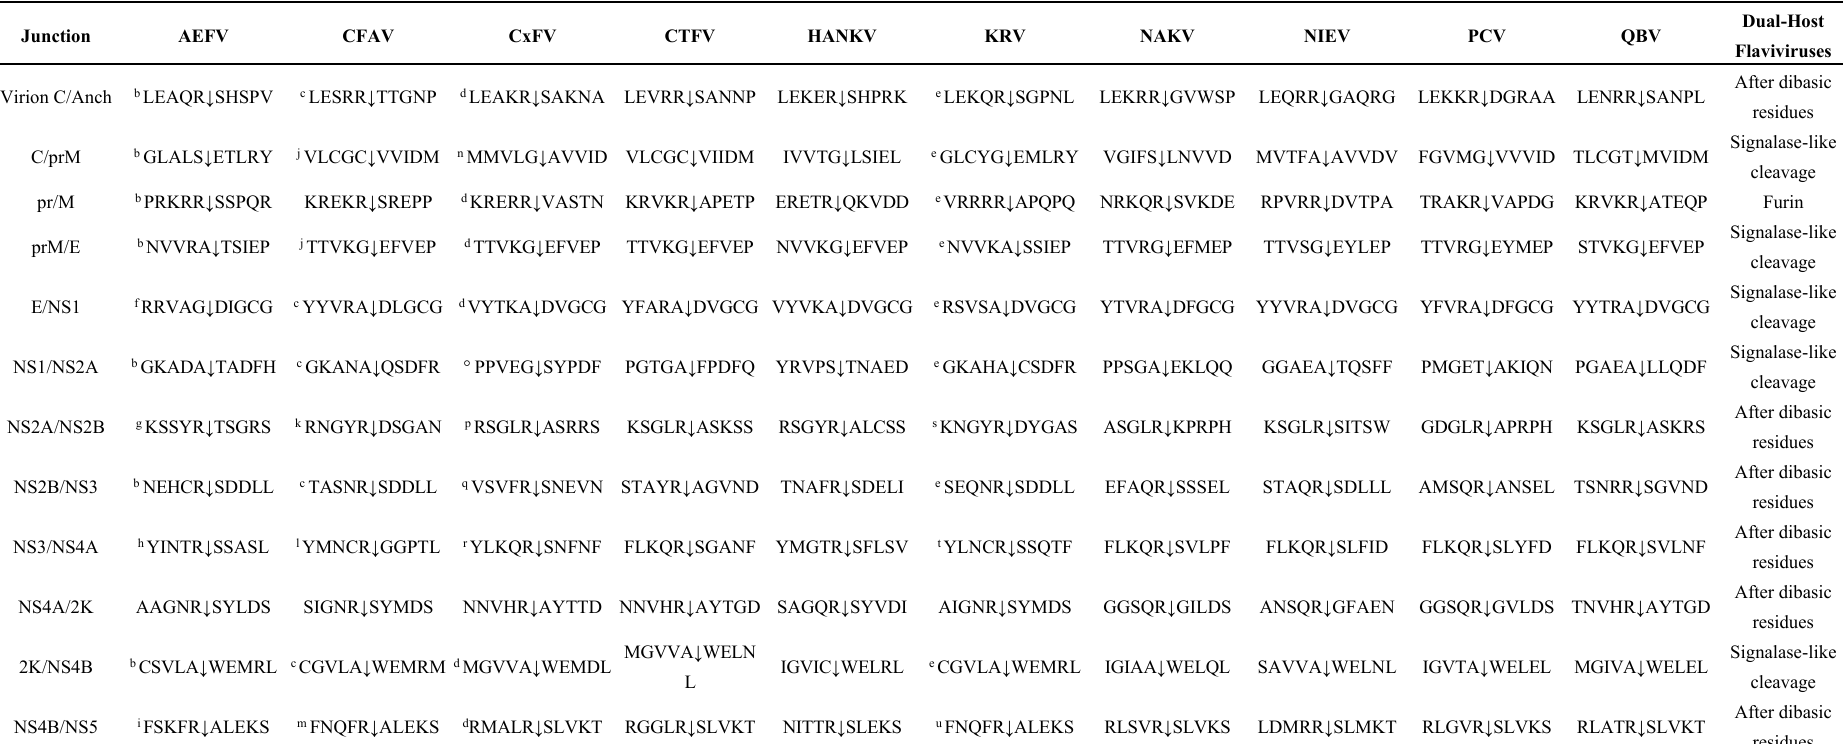
a Table 3. Predicted cleavage sites in the polyproteins of